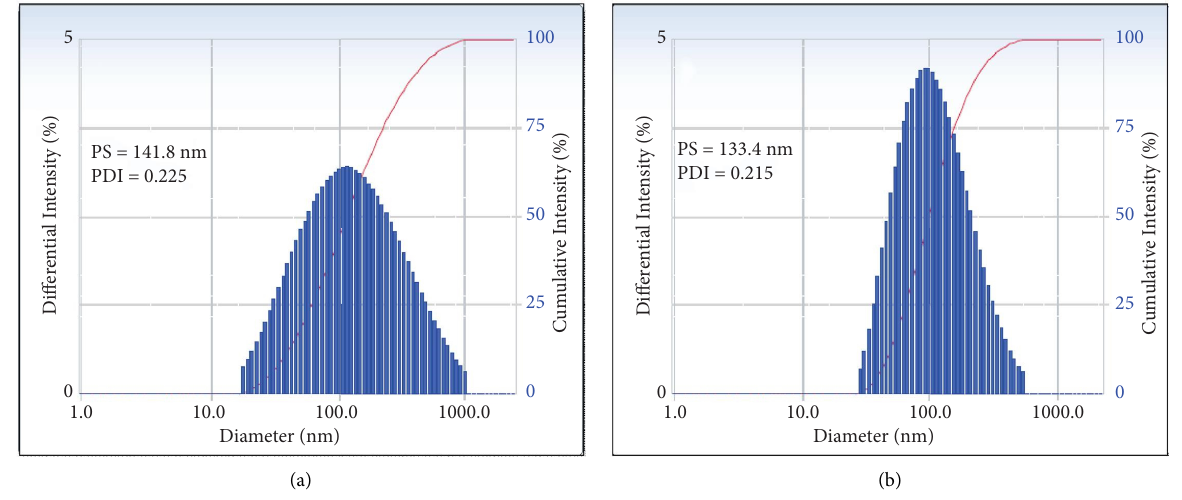
Figure 6: DLS of (a) AU-MNPs and (b) AP-MNPs.